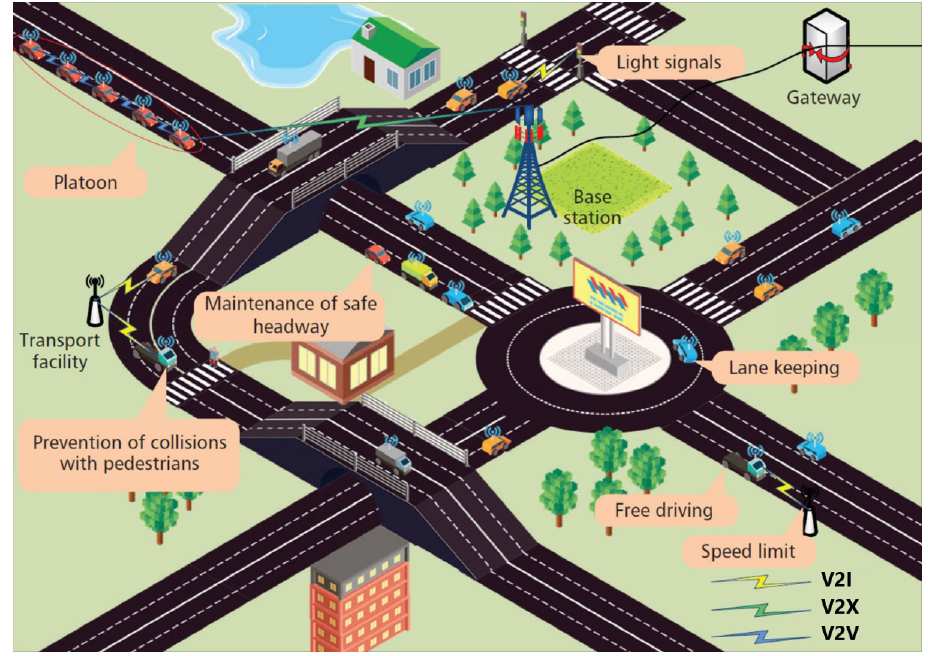
Figure 1. Example of potential SRE scenario with AVs [4].